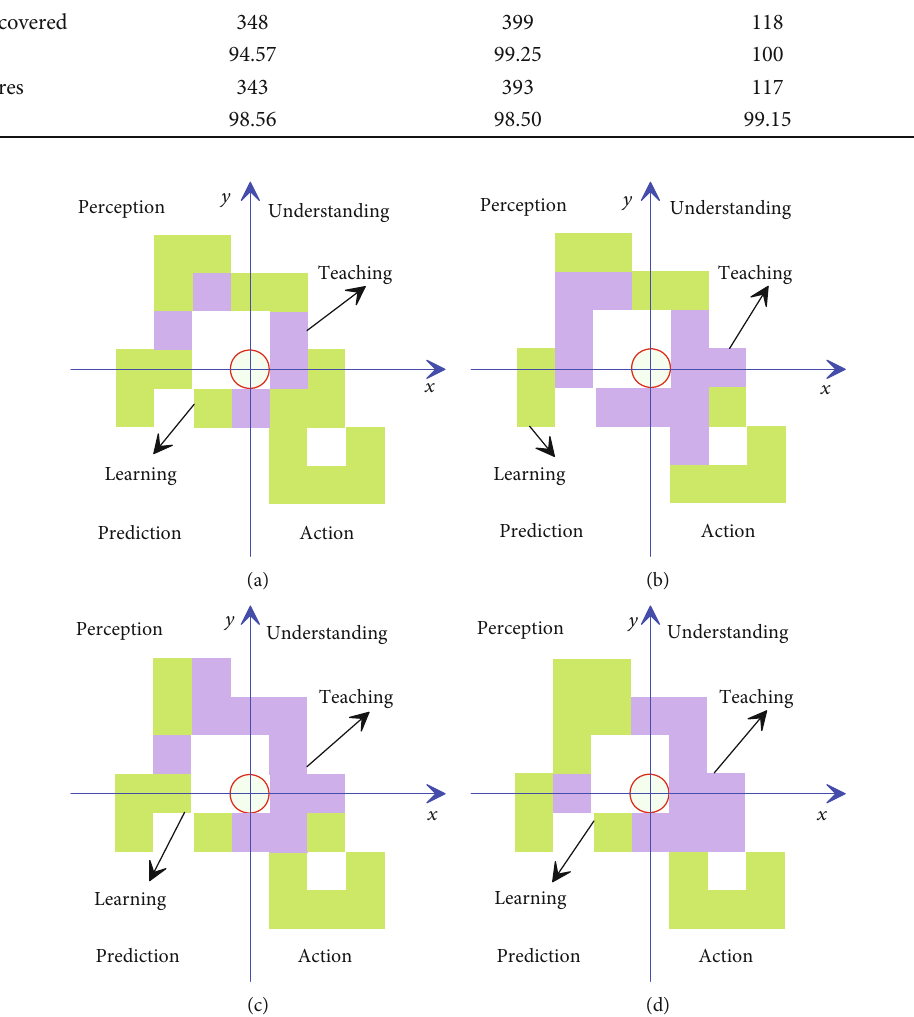
Figure 1: E ff ect of AI on role cognition of teachers or couches (a), students or learners (b), school managers (c), and family members (d) in di ff erent education